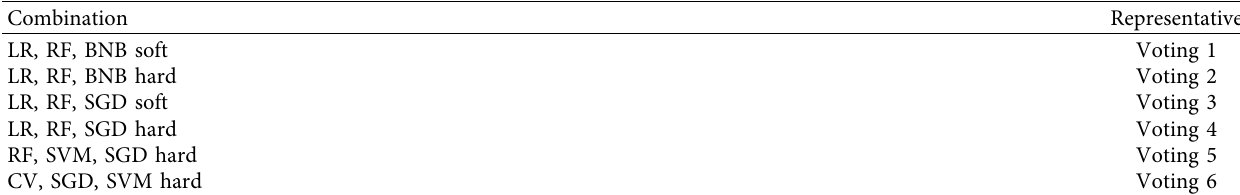
Table 2: An ensemble combination of single